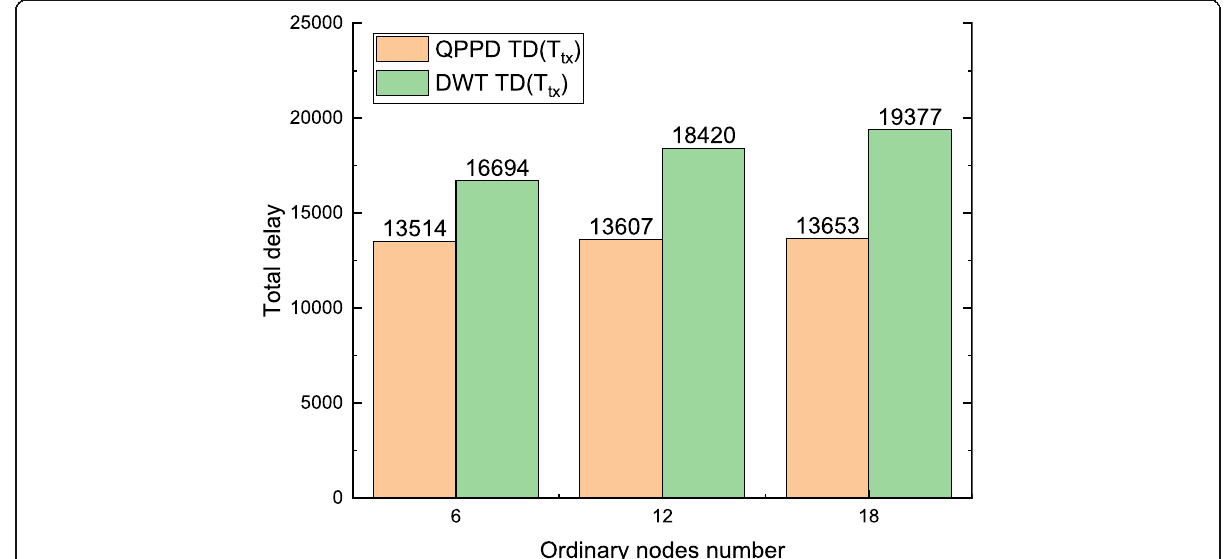
Fig. 36 The total volume of data randomly changes from 0 to 6; the total